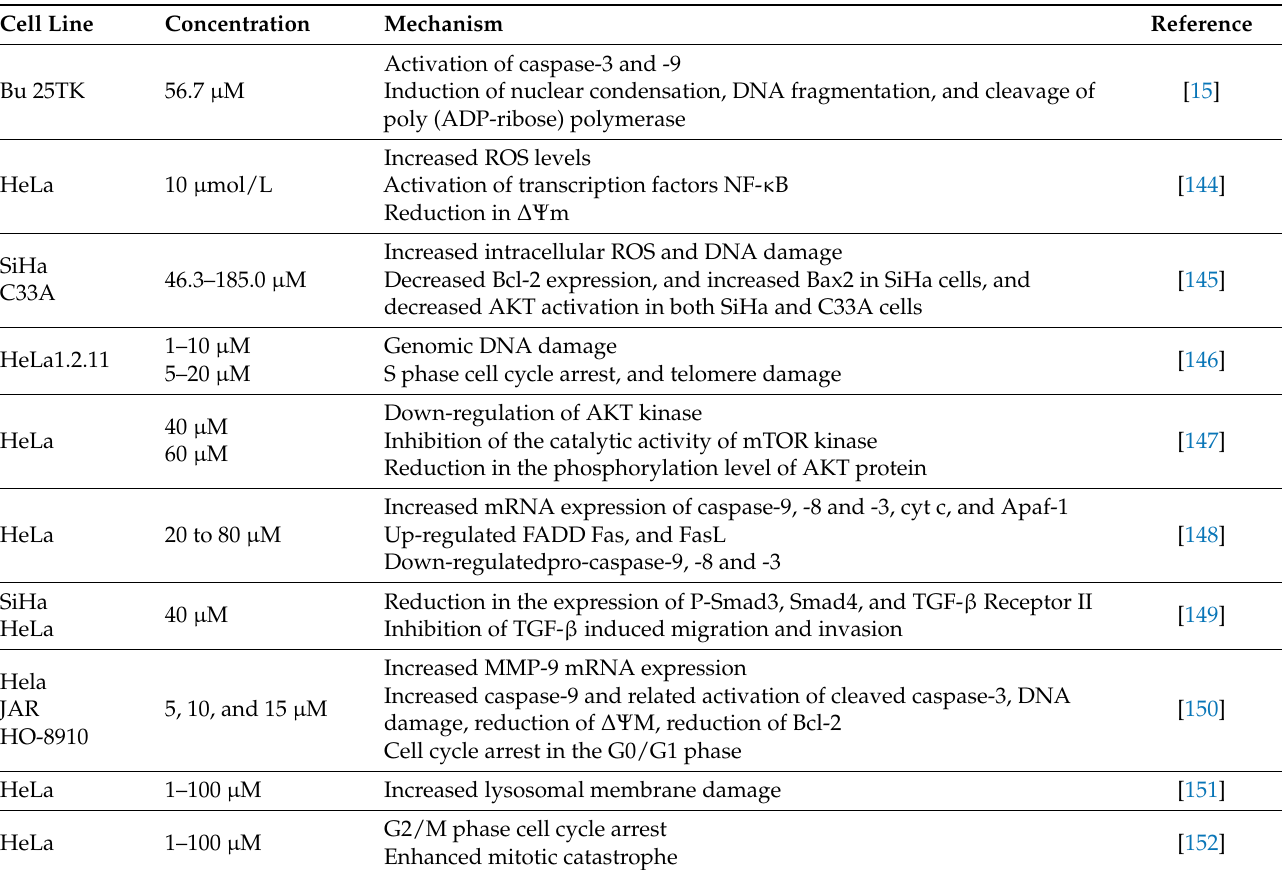
Table 7. Summary of in vitrobiochemical effects of emodin in cervical cancer cell lines. Cell